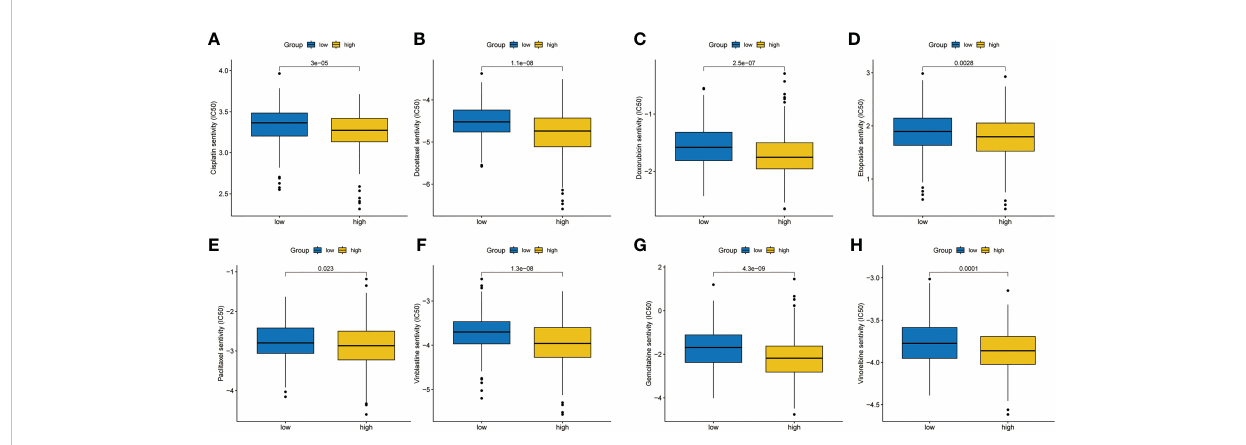
SUPPLEMENTARY FIGURE 1 Univariate cox regression analysis of 33 zinc metabolism-related genes. SUPPLEMENTARY FIGURE 2 Sensitivity of TCGA-LUAD patients to chemotherapy